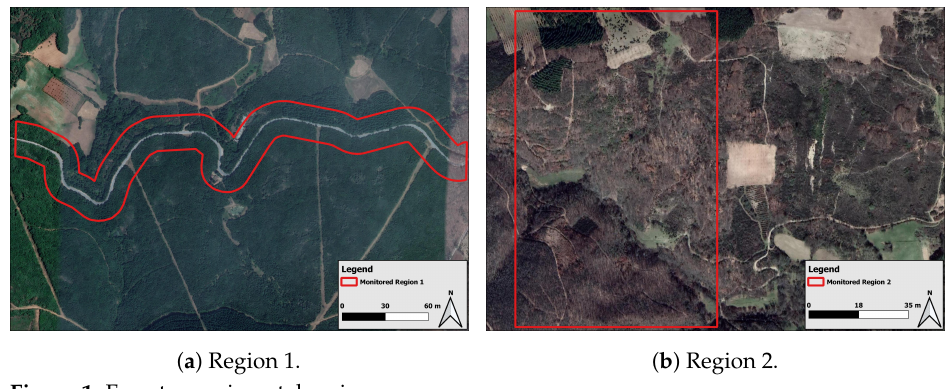
Figure 1. Forest experimental